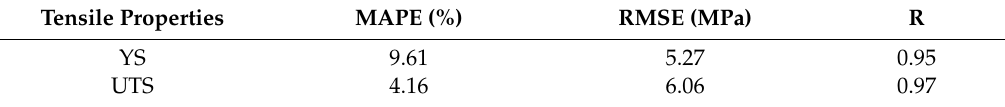
Table 3. Statistical parameters of predicted results for the new data.